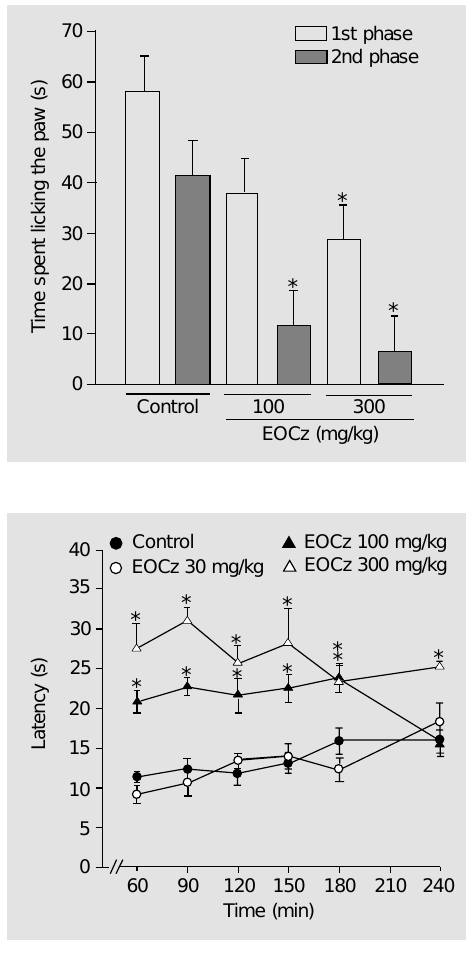
Figure 1. Effects of the essential oil of Croton zehntneri (EOCz) on nociceptive responses to in- traplantar injection of formalin (1%). Ordinate values refer to the time (in s) mice spent licking the paw. Data are reported as means ± SEM (N = 6). *P<0.05 compared to control (ANOVA, Dunn’s test).